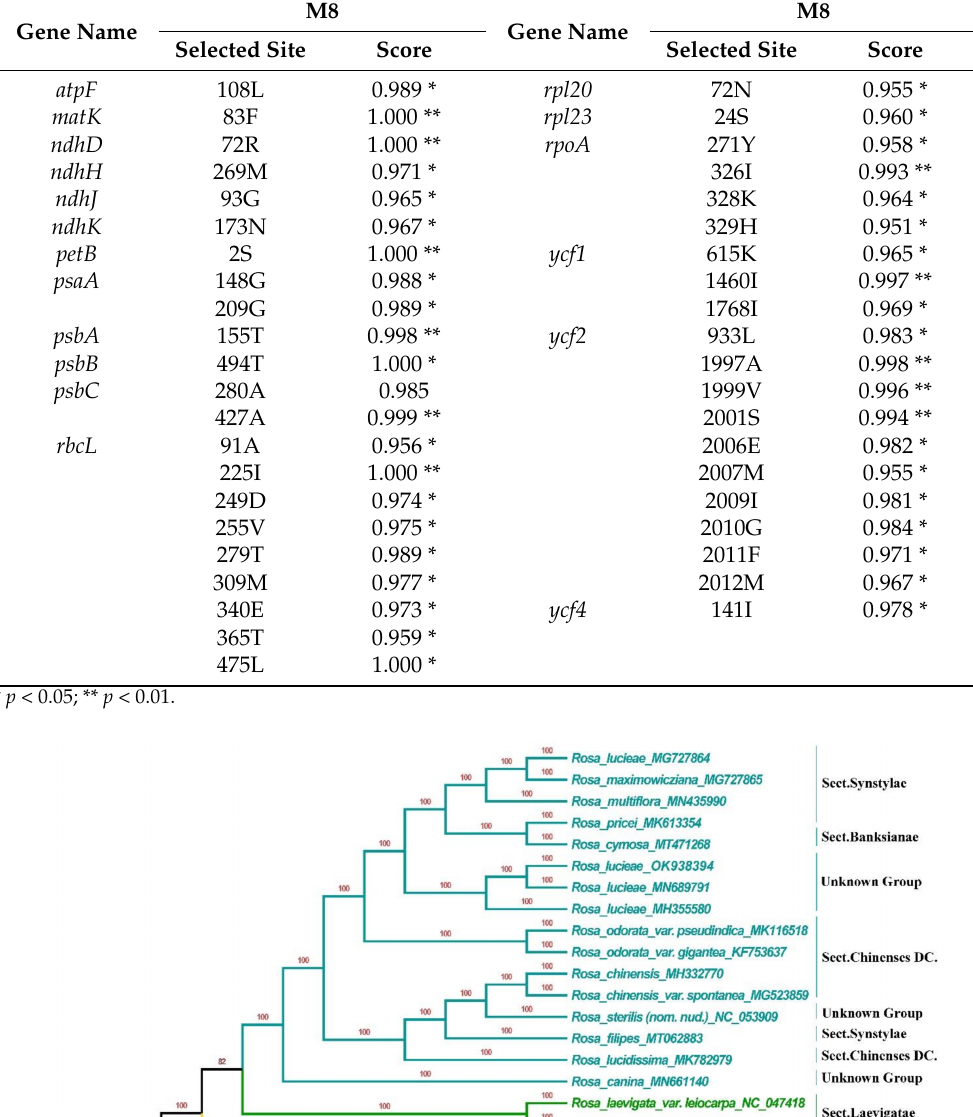
Table 3. Positive selected sites detected in the cp genome of the Rosa .